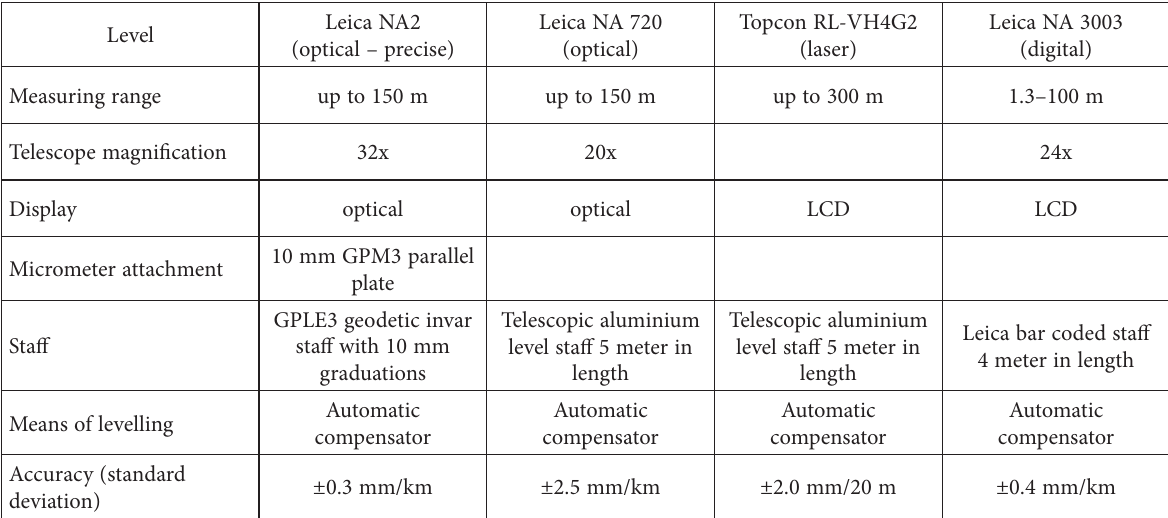
Table 1. Some characteristics of the used